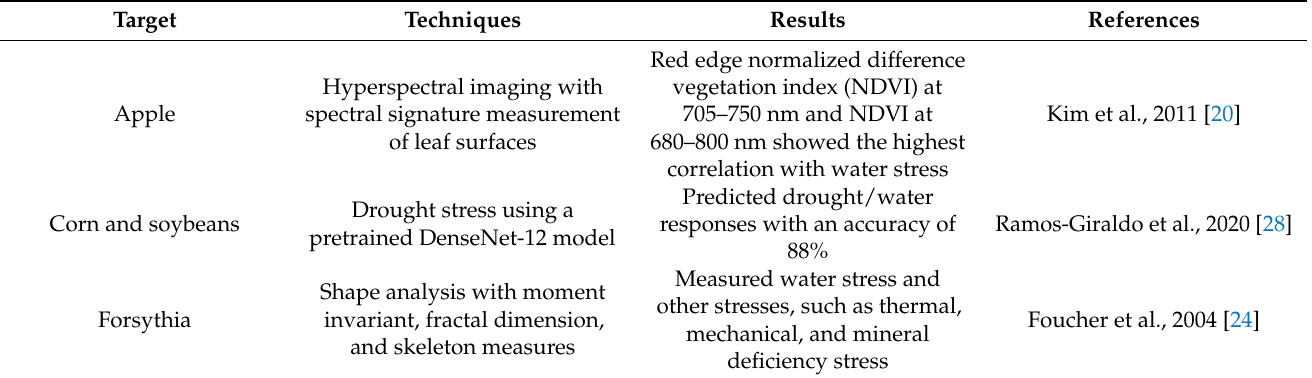
Table 1. Application of machine vision for stress detection in crops.